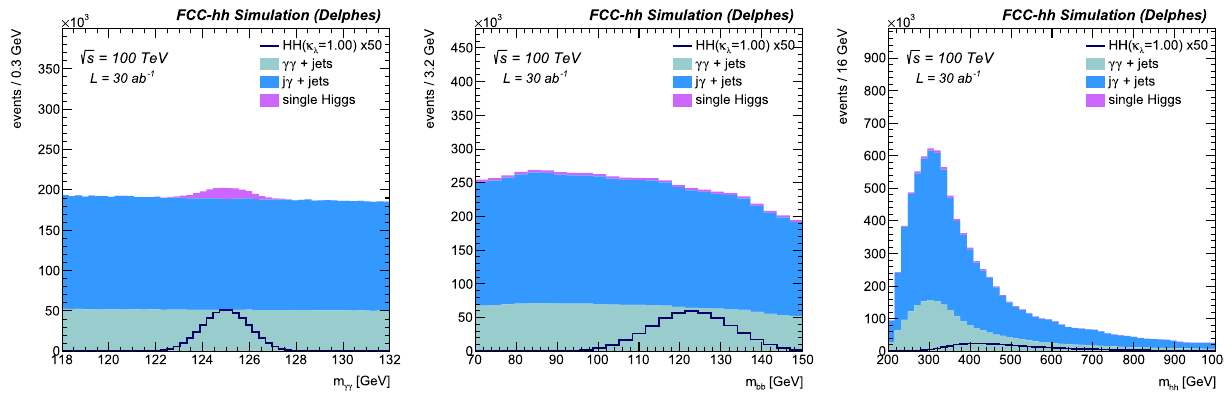
Fig. 5 Invariant mass spectra of the H → γγ ( a ), H → b ¯ b ( b ), HH ( c ) candidates after applying the event pre-selection. The SM Higgs pair process is normalized to 50 times the expected yield with L int = 30 ab − 1